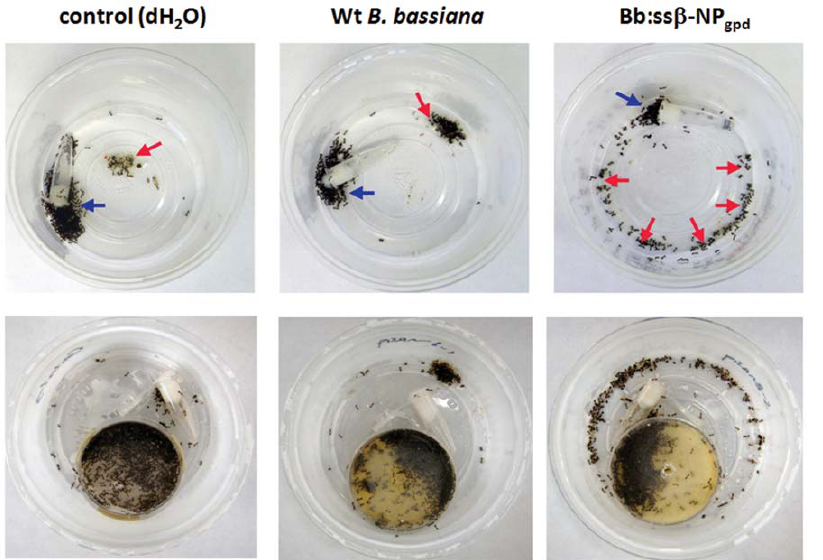
Figure 2. Distribution of dead ants after infection with WT and Bb::sp b -NP gpd B.bassiana strains in mock mound assays. Top panels, ants in arenas with 10% sucrose, but no nest area, bottom panels, test arenas containing 10% sucrose and nest area. Blue arrows in top panels indicate the location of the majority of live ants, in the bottom panels, the most of the live ants are in the nest area (small petri dish in test arena). Red arrows indicate the presence of well defined ‘‘bone piles’’ in the control and WT B. bassiana infected ants, and a more random distribution of dead ants in the b -NP expressing B. bassiana infected ants.